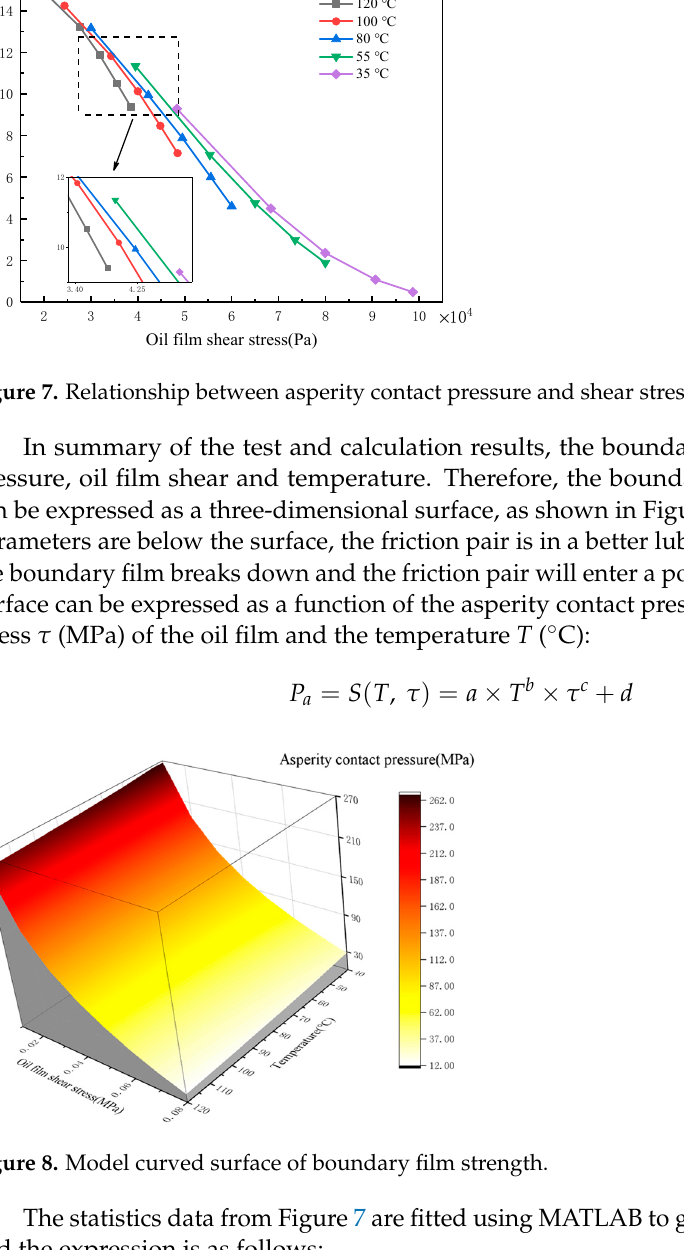
Figure 6. Variation of friction coefficient with temperature.